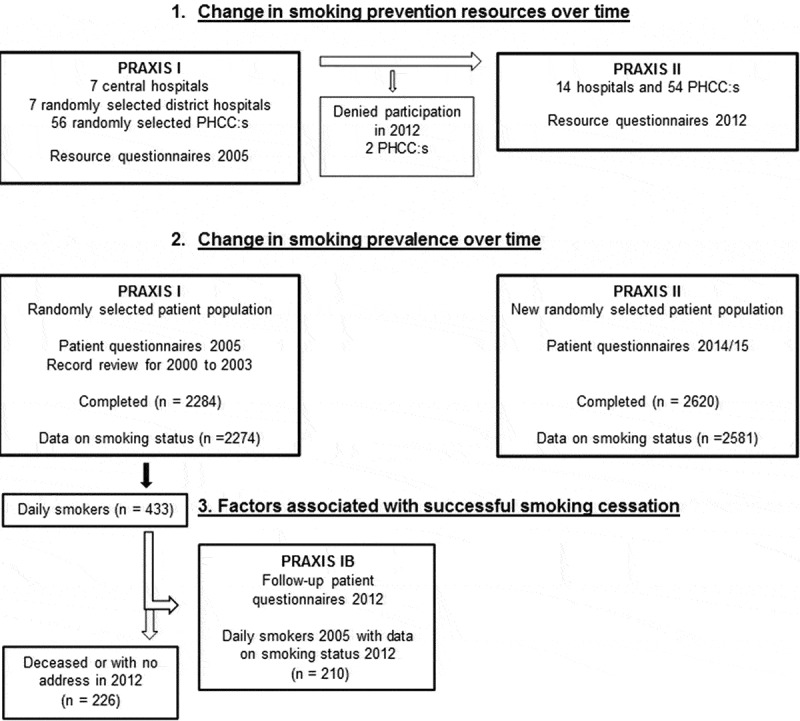
Flow chart.Flow chart of cohorts and data collection for the three major research questions of the study. PRAXIS I is referring to the first cohort from 2005, PRAXIS IB to the follow-up in 2012 of the first cohort, and PRAXIS II to the second cohort from 2014/2015. PHCCs = primary health care centers.